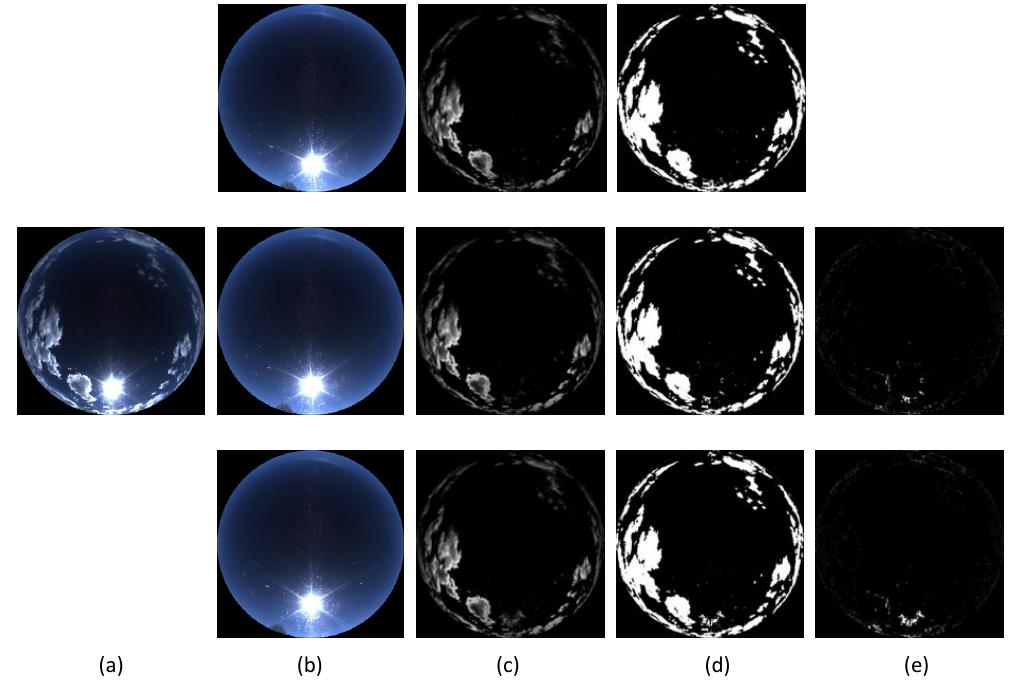
Figure 6. Sensitivity test for low solar elevation angle. Panel (a) is the TCI image after rotation, which was captured on 11 October 2012, column (b) shows the CSB images, where the first row has completely the same solar elevation angle as (a) , the solar elevation angle of the second row has 2 ◦ deviation with (a) , and the solar elevation angle of the third row has 5 ◦ deviation with (a) , (c) shows the difference images, (d) shows the corresponding cloud detection results, and (e) represents the differencing results between the 2 and 5 ◦ offset with the baseline result in row 1.